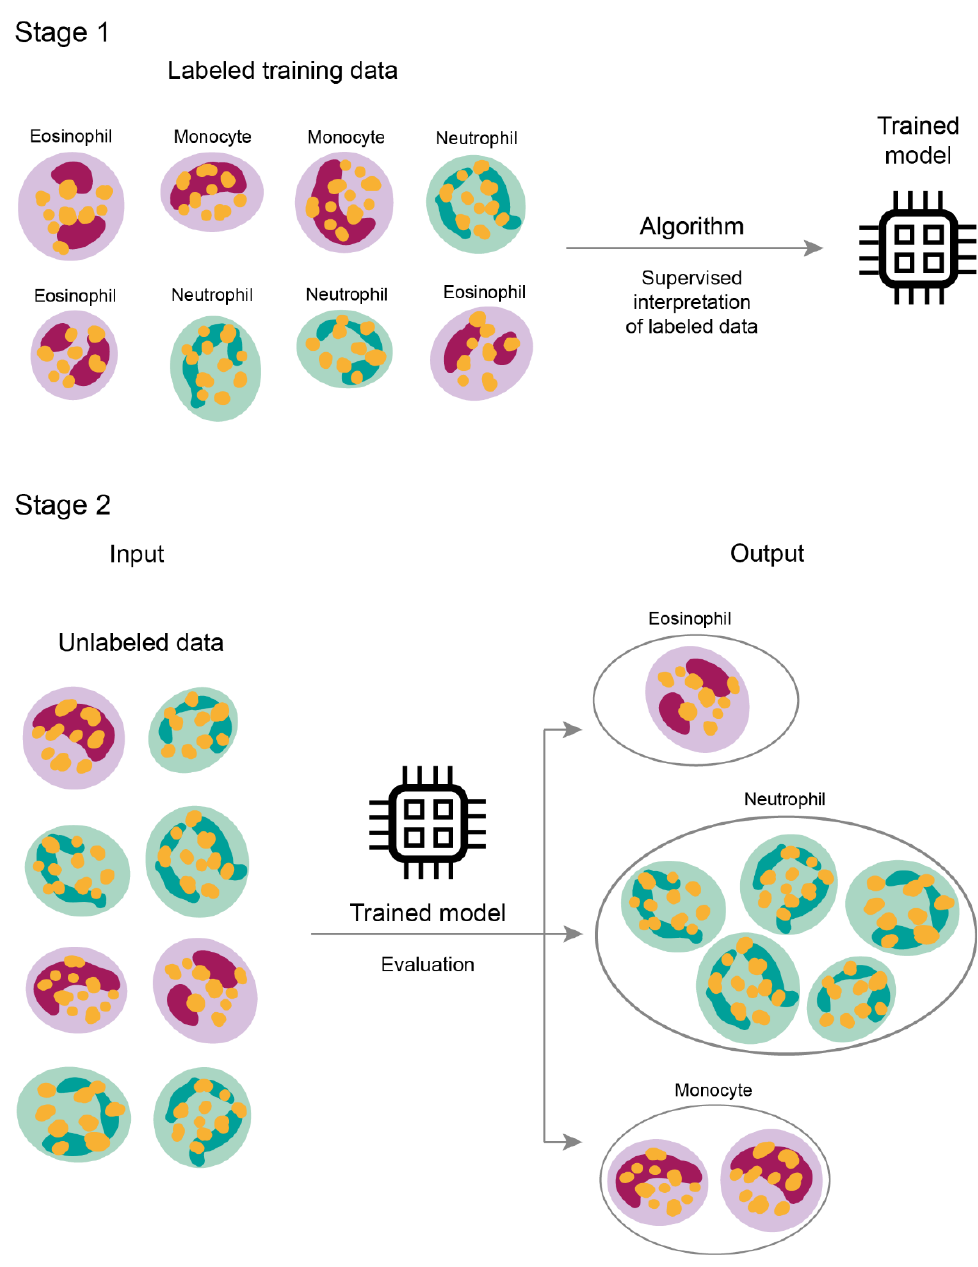
Figure 2. Supervised learning model. In the supervised method, learning begins on a labeled dataset, where input data is linked to its output label. The algorithm is then validated on a different, non-labeled dataset, not presented to the machine previously.